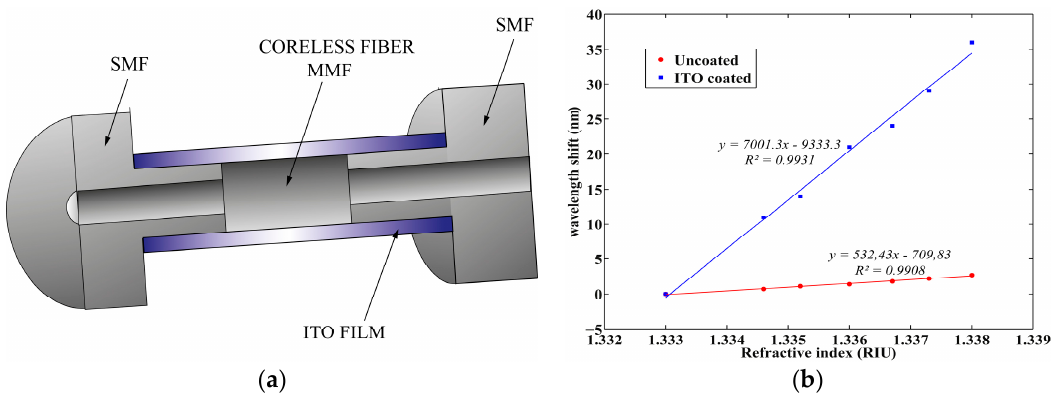
Figure 1. ( a ) Etched SMS structure with an ITO thin film deposition; ( b ) Wavelength shift with refractive index uncoated and ITO